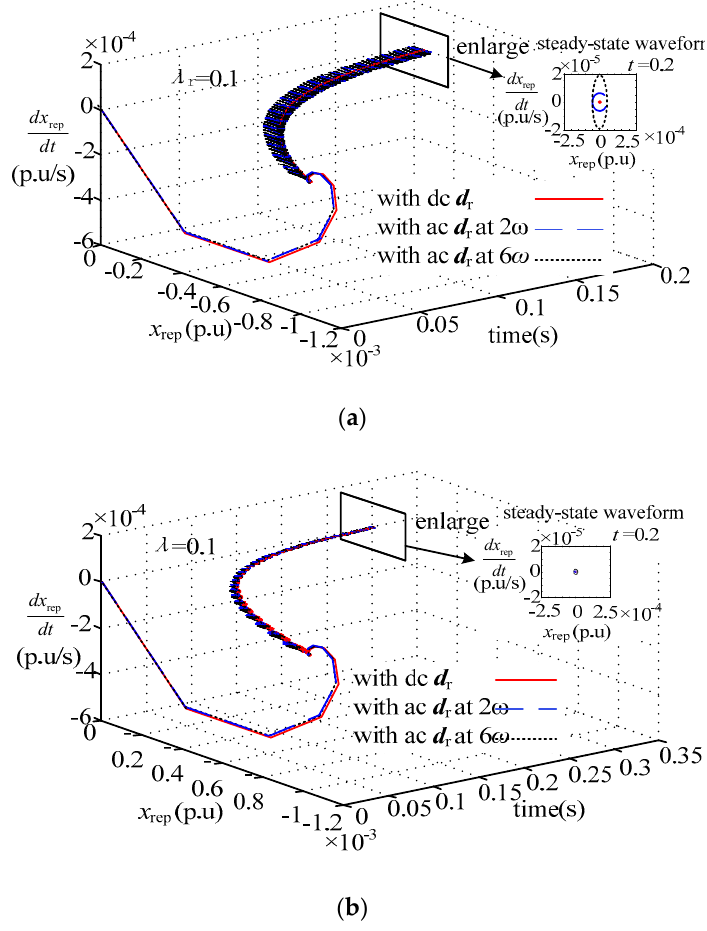
Figure 4. Phase plane trajectory with disturbances. ( a ) Phase plane trajectory with disturbances of integral sliding mode control (ISMC); ( b ) Phase plane trajectory with disturbances of multi-resonant-based sliding mode control (MRSMC).